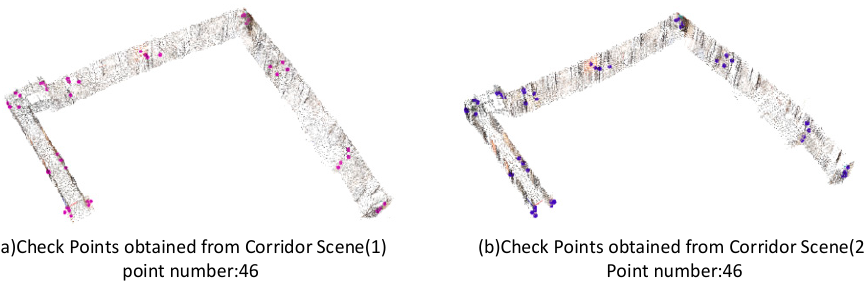
Figure 12. Corridor scenes, marked with the checkpoints, ( a ) checkpoints obtained from corridor scene (1); ( b ) checkpoints obtained from corridor scene (2).